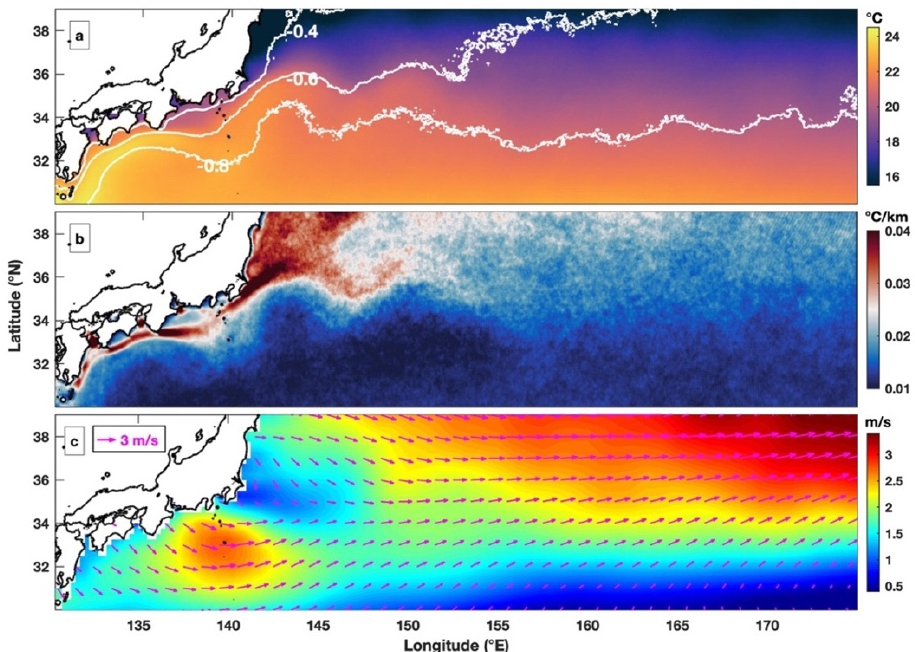
Figure 2. ( a ) Averaged sea surface temperature (SST, ◦ C) overlaid with contours of the averaged Chl-a (log 10 (mg/m 3 )), ( b ) the averaged SST gradient ( ◦ C/km), and ( c ) the averaged wind speed magnitude (shading) overlaid with wind vectors in the KE